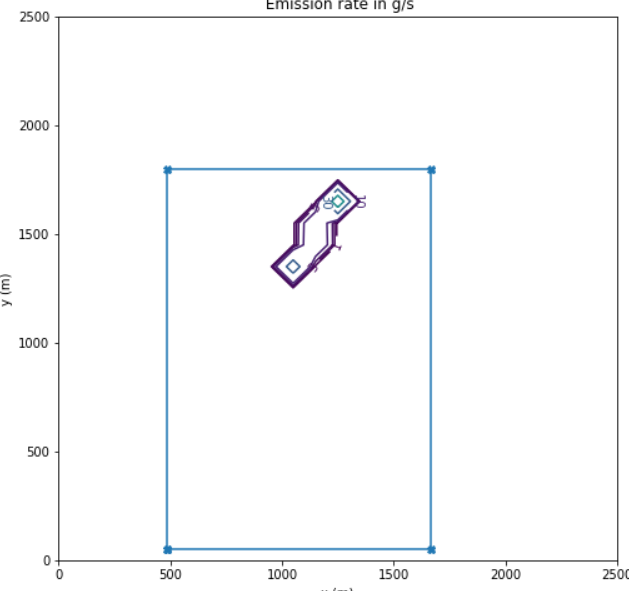
Figure 11. Scatter plot of measured methane concentrations versus modeled concentrations for 14 September 2021, 9:04 a.m. to 9:23 a.m. R denotes the correlation coefficient. The (orange) regression and (blue) 1:1 lines are also displayed.